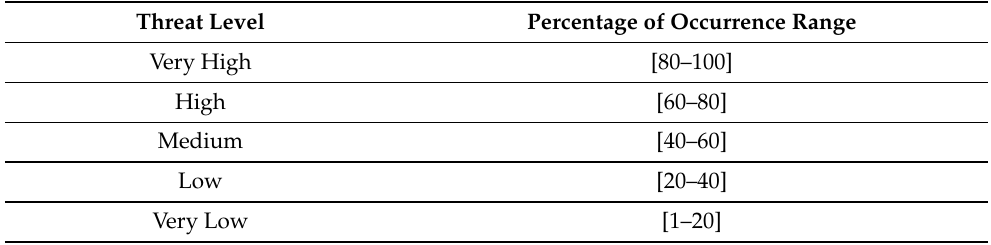
Table 4. Threat level and corresponding percentage of occurrence in the